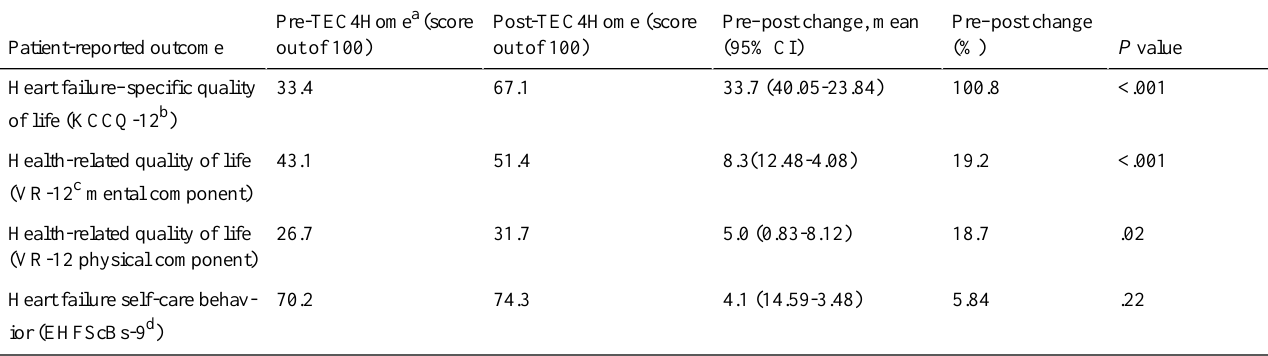
Table 3. Patient-reported outcomes pre- and